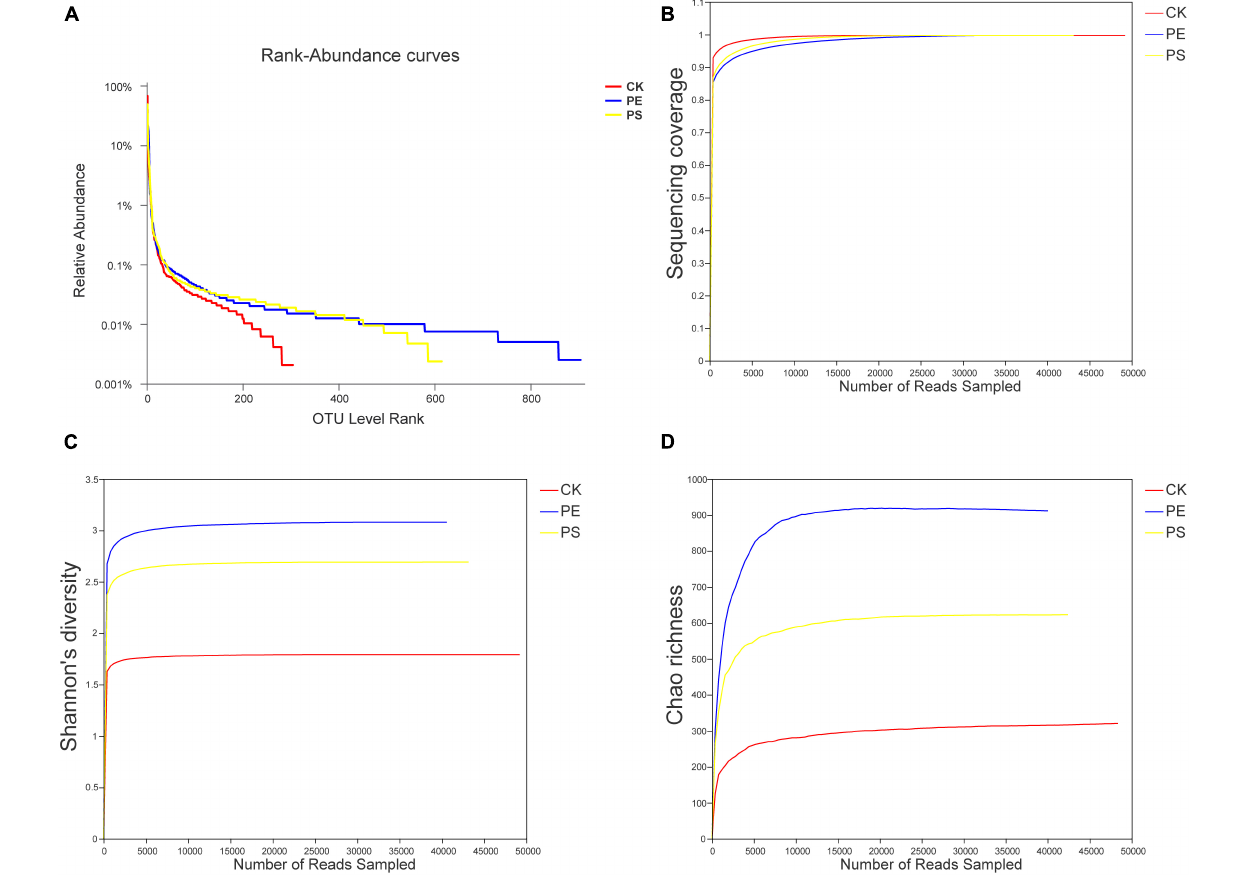
FIGURE 7 | Changes of the diversity of intestinal microbes in different groups. (A) Rank-abundance curves, (B) sequencing coverage curves, (C) Shannon diversity curves, and (D) Chao richness